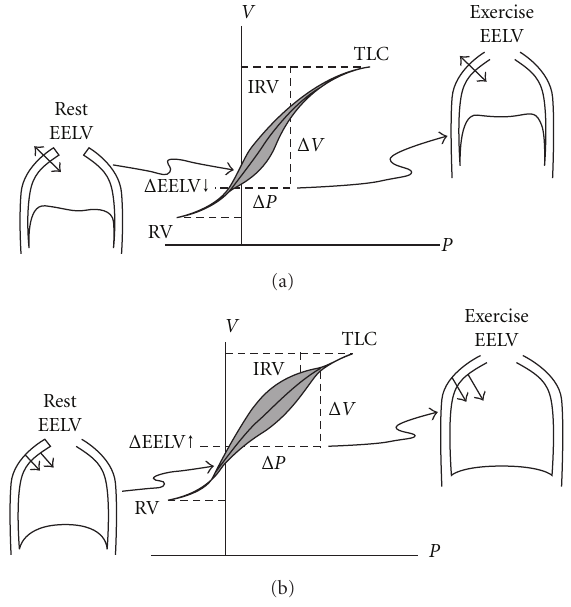
Figure 1: Pressure-Volume ( P-V ) relationships of the total respira- tory system in (a) normal and (b) chronic obstructive pulmonary disease (COPD). Tidal P-V curves during rest and during exercise are shown. In COPD individuals, there is a resetting of the respiratory system’s relaxation volume to a higher level than in the healthy individuals. Hyperinflation in COPD leads to increased EELV, RV and a corresponding reduction in IRV, in comparison to normal condition. In contrast to normal lung, the combined recoil pressure of the lungs and chest wall in hyperinflation is inwardly directed during rest and during exercise. This results in inspiratory threshold load on the inspiratory muscles with consequential decrease in the zone of apposition (shown in P-V curve (b) during rest and exercise). EELV: end-expiratory lung volume, RV: residual volume, IRV: inspiratory reserve volume, TLC: total lung capacity. From O’Donnell and Laveneziana